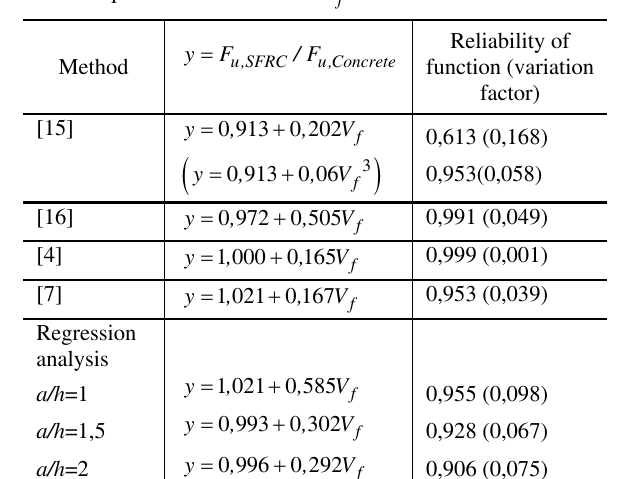
Fig 10. Graphical representation of